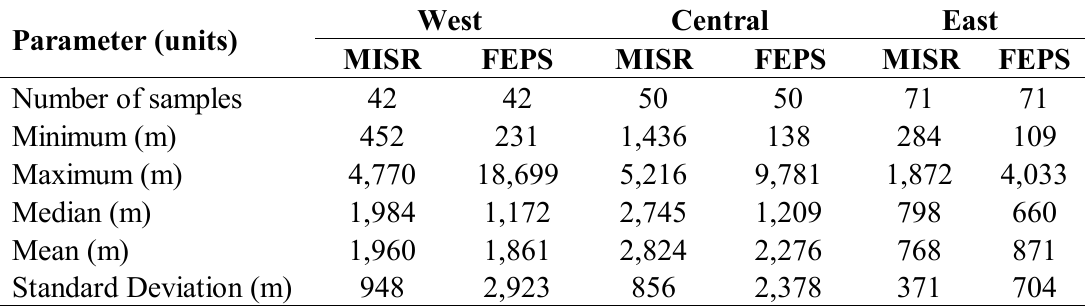
Table 2. Comparison of the overall distributions of observed median wind corrected plume top heights from the MISR instrument and modeled plume top heights from FEPS by region. Plume height units are meters (m) above ground level. Region definitions are shown in Figure 6.